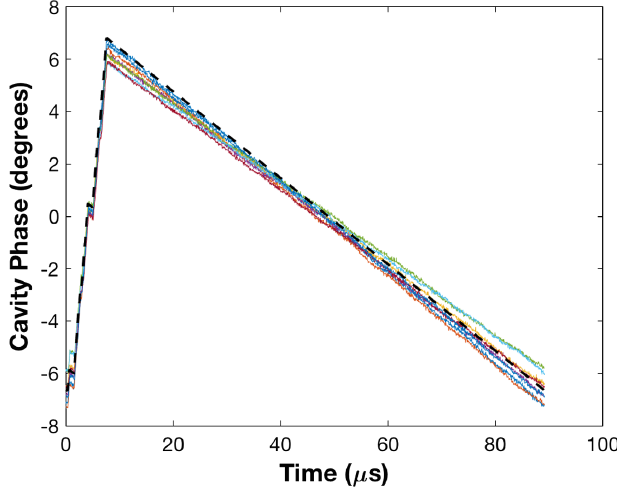
FIG. 14. Beam 2 abort gap population and klystron 1B2 forward power. The yellow line indicates when the algorithm is on/off. The blue line shows the abort gap population and the red line the klystron power.